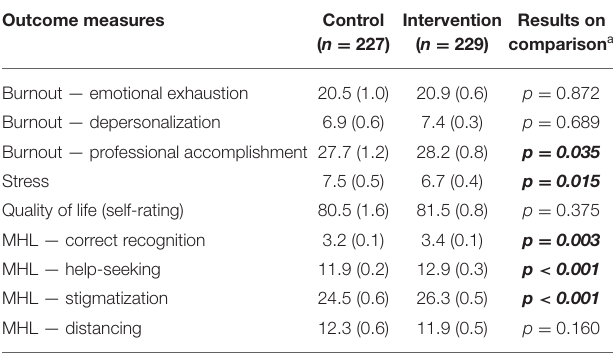
TABLE 2 | Mean (s.e.) of the outcome measures assessed at the completion of the intervention program by groups and results on comparisons. Outcome measures Control